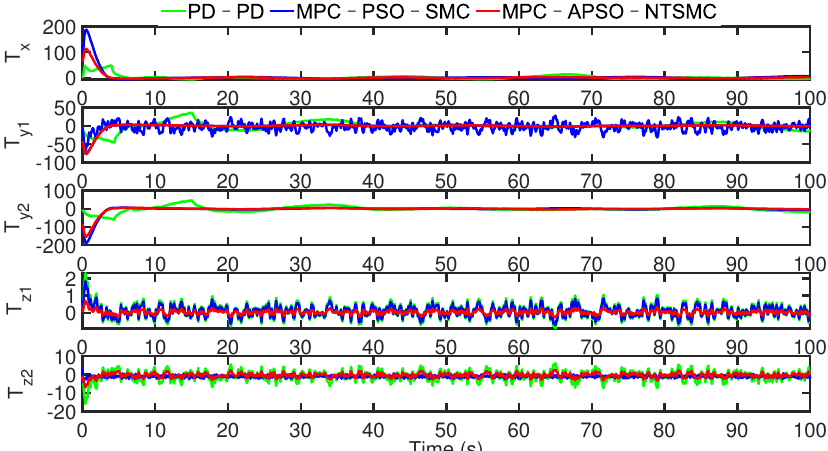
Figure 27. The thrust of thrusters for the tracking task with random disturbance for Case 2.